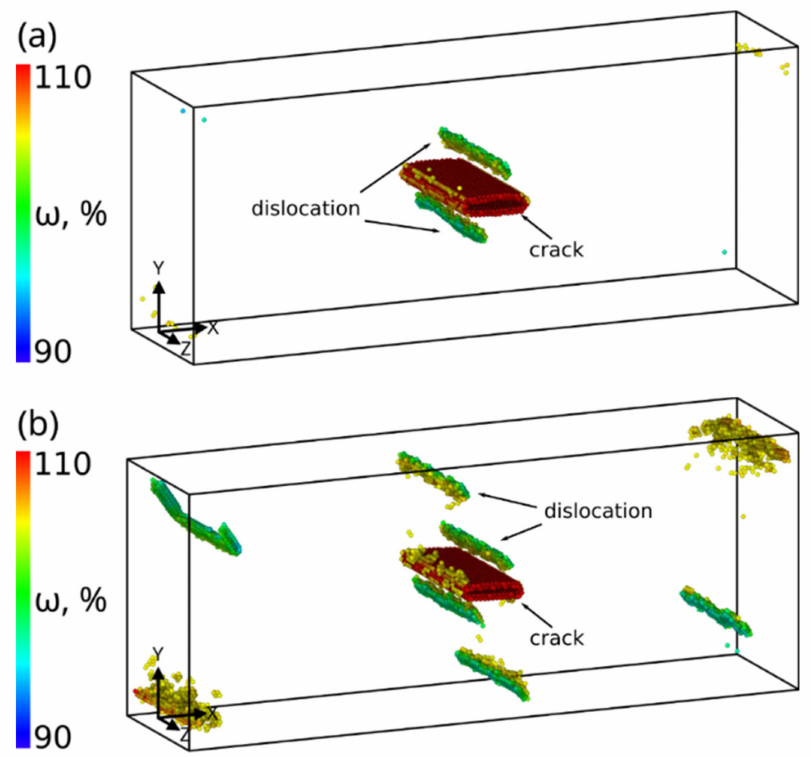
Figure 10. Defect structure at 4.5% ( a ) and 7.4% ( b ) shear deformation for sample with (011)[011] crack. Bcc atoms with volume <105% are not